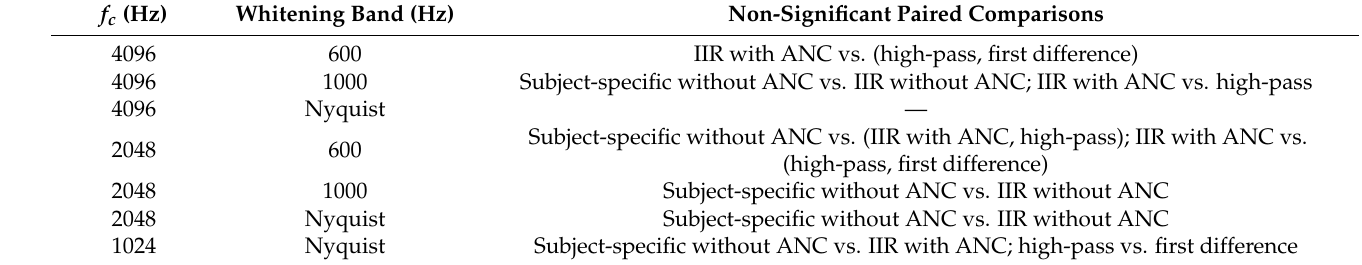
Table 3. Study 2 whitening method statistical results: this table lists non-significant paired comparisons between whitening methods after fixing the sampling rate and whitening band limit (RDS processing used). ANC = adaptive noise canceling. Sampling rate = f c